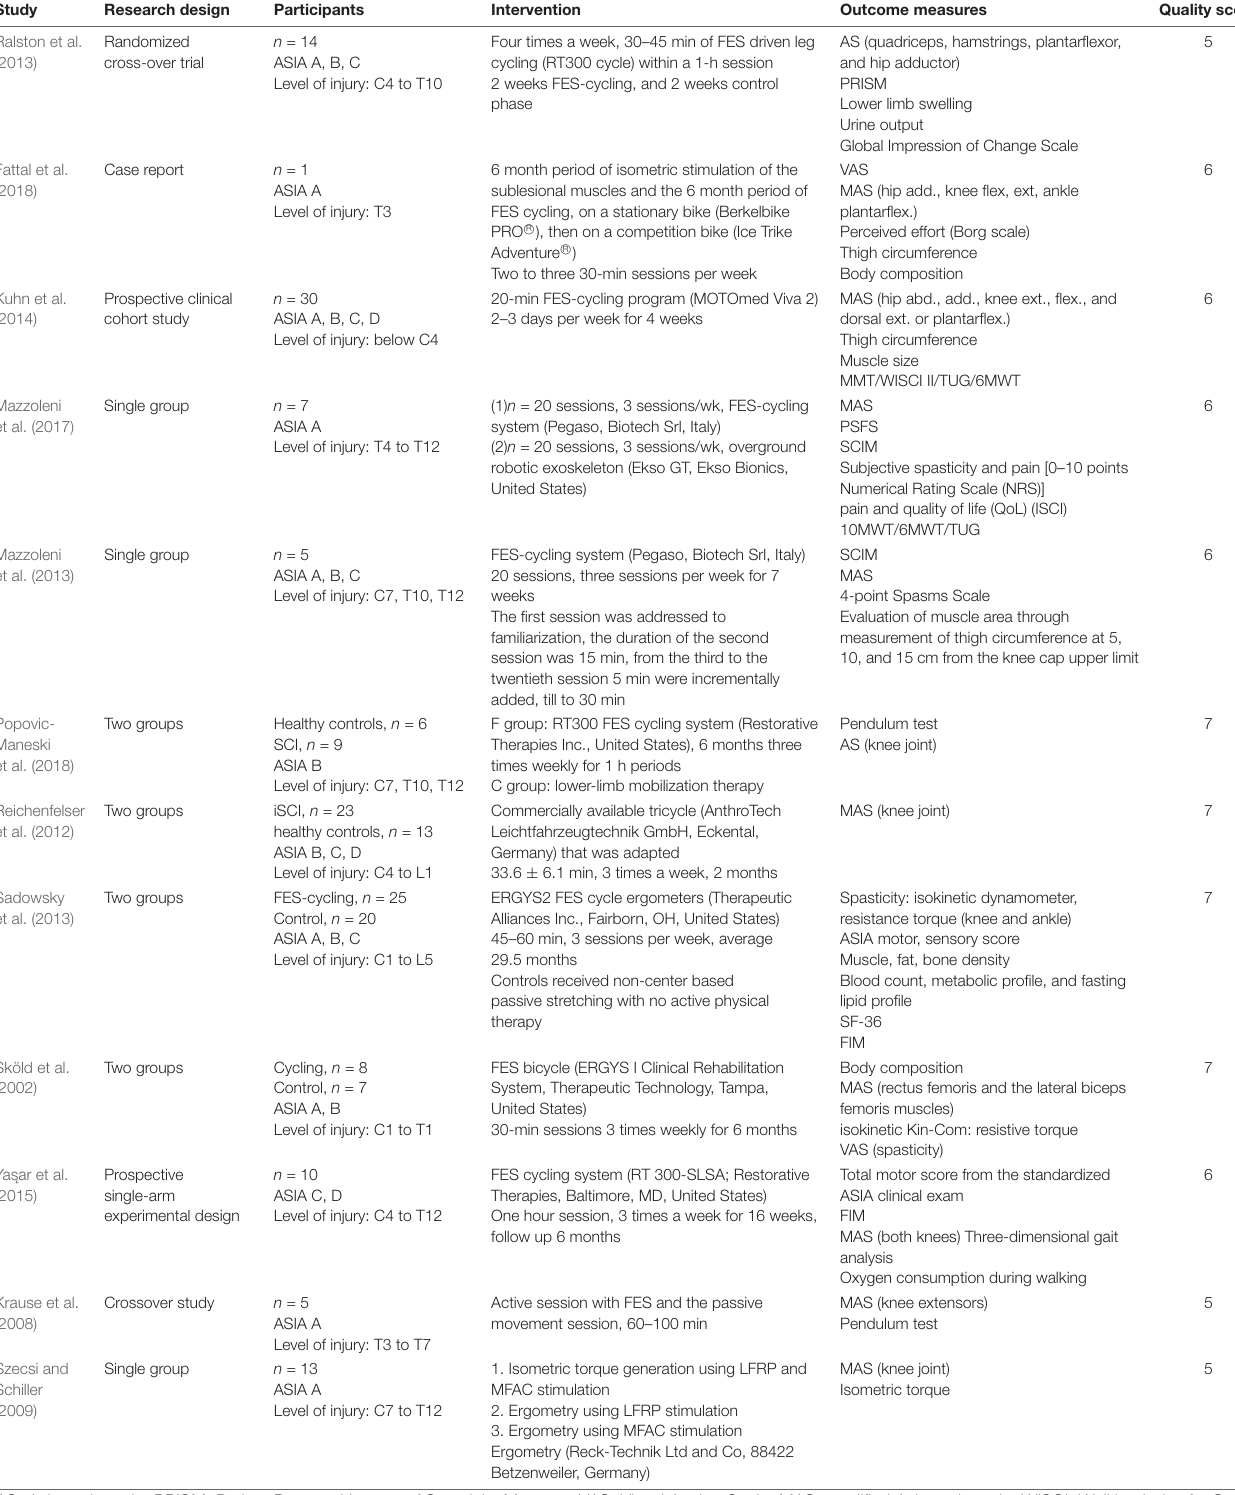
TABLE 1 | The characteristics of the included studies.